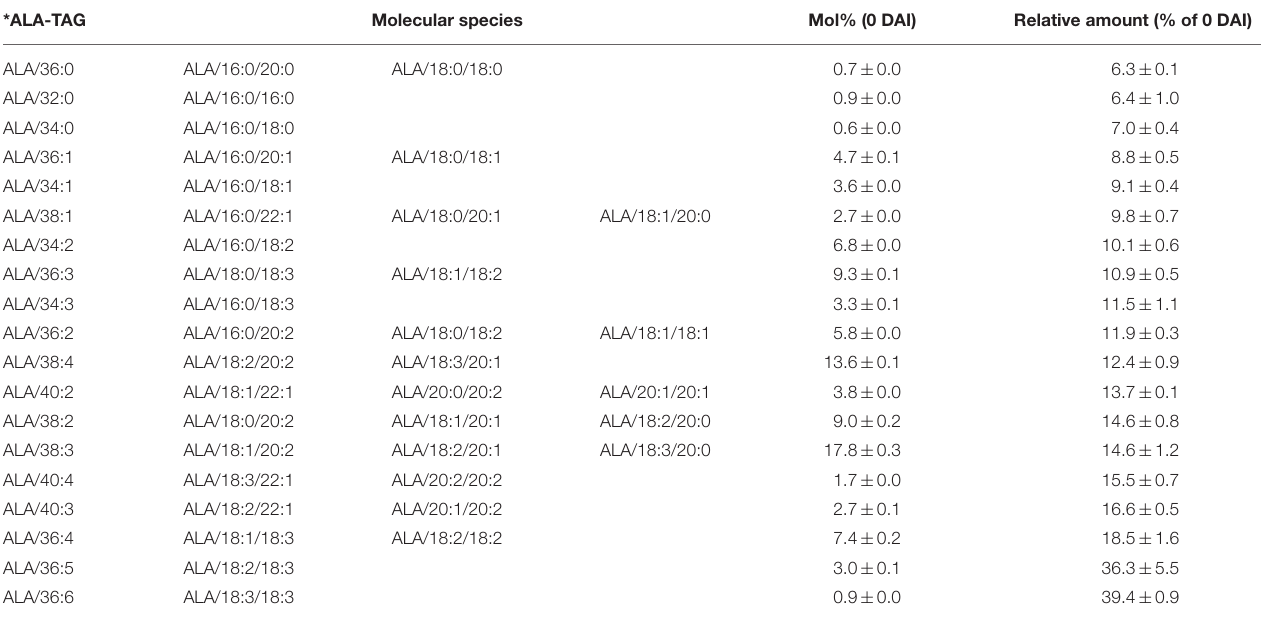
* Sum of carbon and double bond numbers in other two acyls of ALA-TAG. Species containing minor fatty acids ( < 0.5%) are not shown.